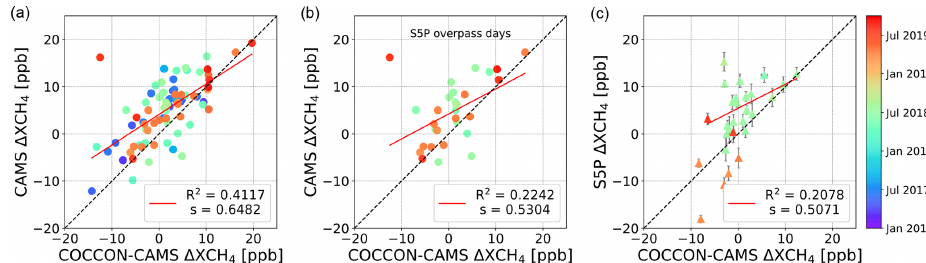
Figure 12. Difference in XCH 4 measured between Kiruna and Sodankylä. (a) Plot showing the comparison between CAMS and COCCON- CAMS. (b) Plot showing the comparison between CAMS and COCCON-CAMS during the S5P overpass days. (c) Plot showing the com- parison between S5P and COCCON-CAMS. The annotations follow those in Fig.